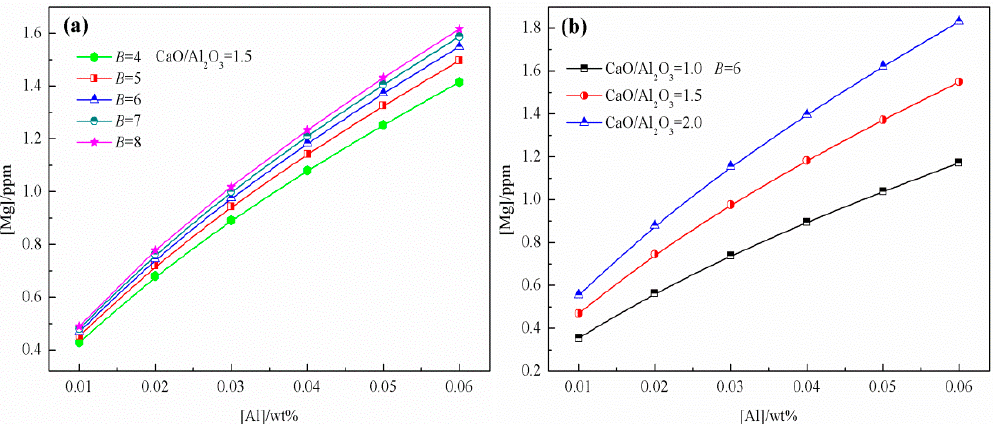
Figure 7. Al–Mg equilibria at various basicities and CaO/Al 2 O 3 ratiosin the slag: ( a ) Effect of basicities at a fixed CaO/Al 2 O 3 ratio; ( b ) effect of CaO/Al 2 O 3 ratios at a fixed basicity.